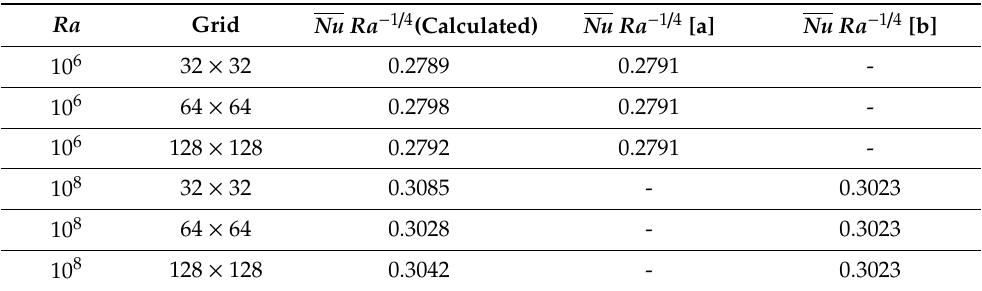
Table 1. Comparison between the calculated mean Nusselt number and the results of De Vahl Davis [34] and Le Qu é r é [35].